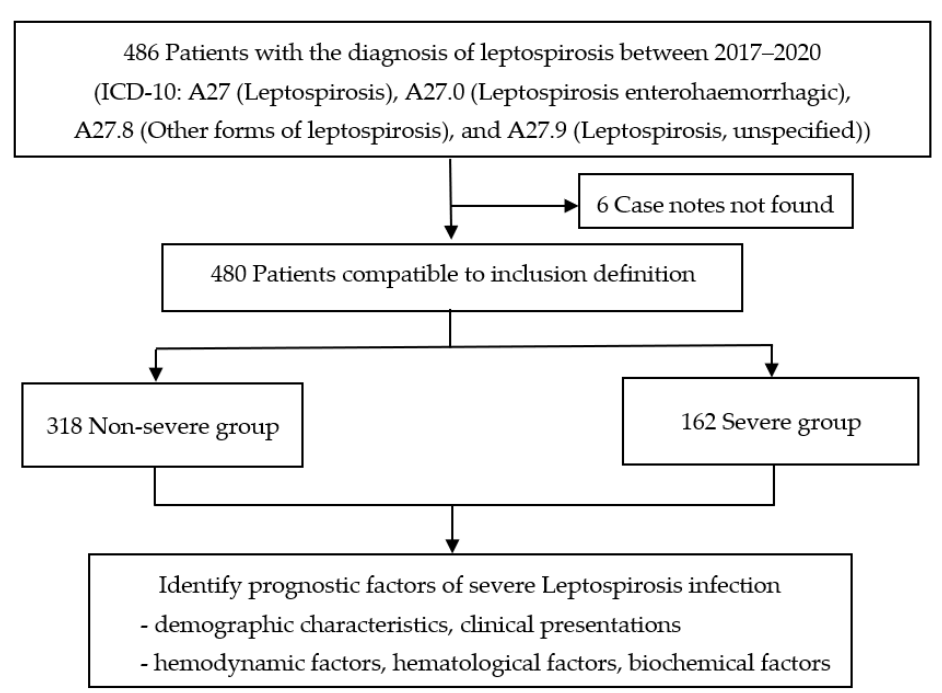
Figure 1. Study flow diagram.